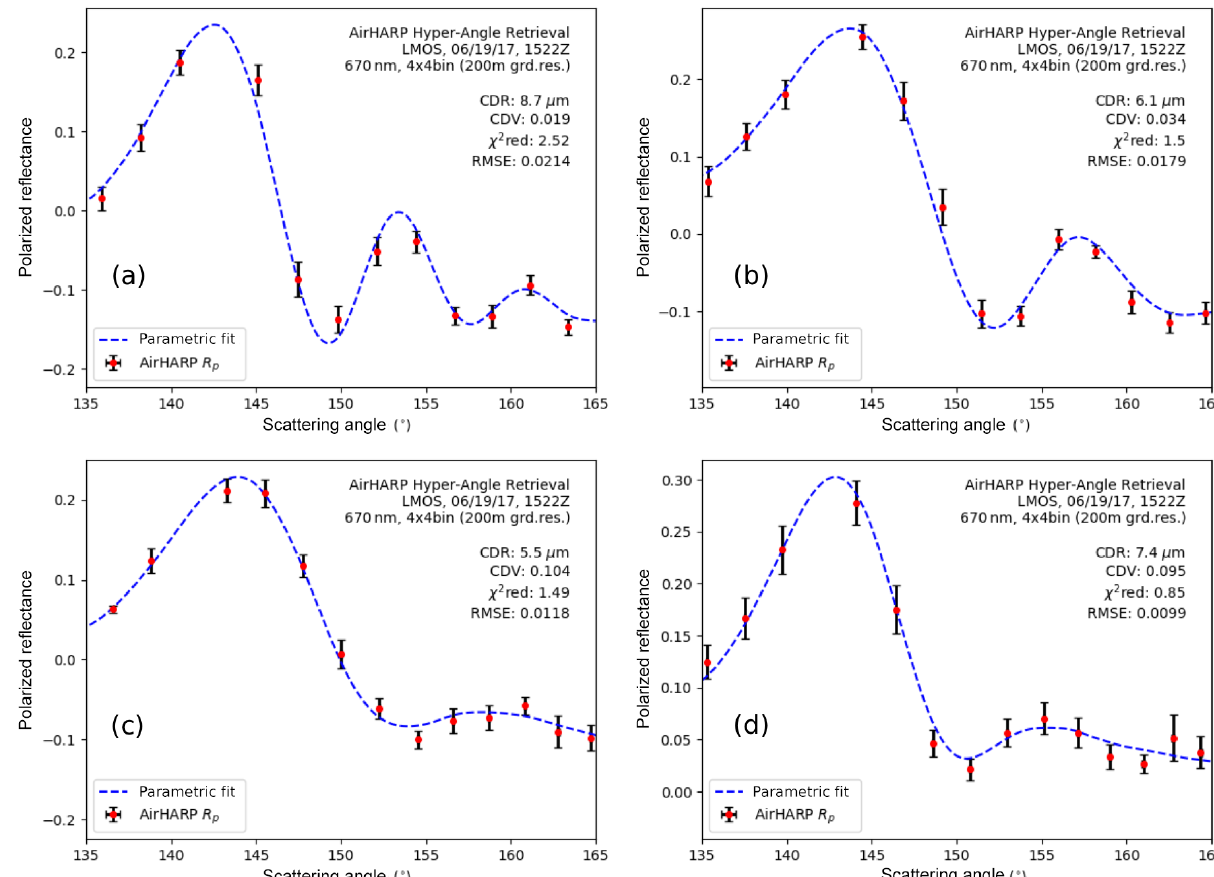
Figure 6. Several examples of the traditional parametric fit retrieval applied to AirHARP hyper-angular polarized reflectance measurements for 200m superpixels. Panels (a) and (b) signify narrow DSDs with small CDV values. In panels (c) and (d) , the eroded supernumerary bows suggest wider DSDs. Error bars represent the 2 σ standard deviation of the measurements inside the superpixel. Note that while the χ 2 (a) is larger than our 1.5 threshold, the overall fit to measurement generates a valid